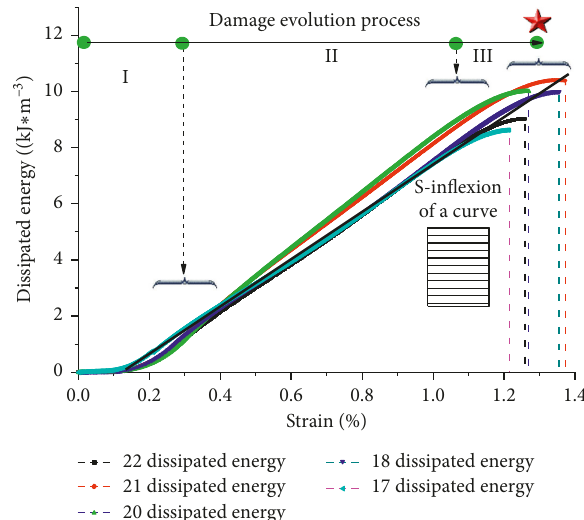
Figure 8: Relationship curves between strain and dissipative en- ergy damage evolution